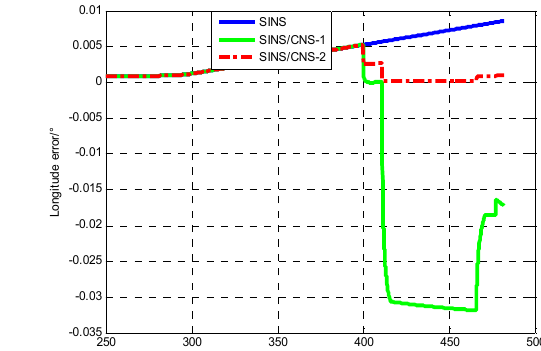
( a ) The lattitude error results of three methods ( b ) The longititude error results of three methods